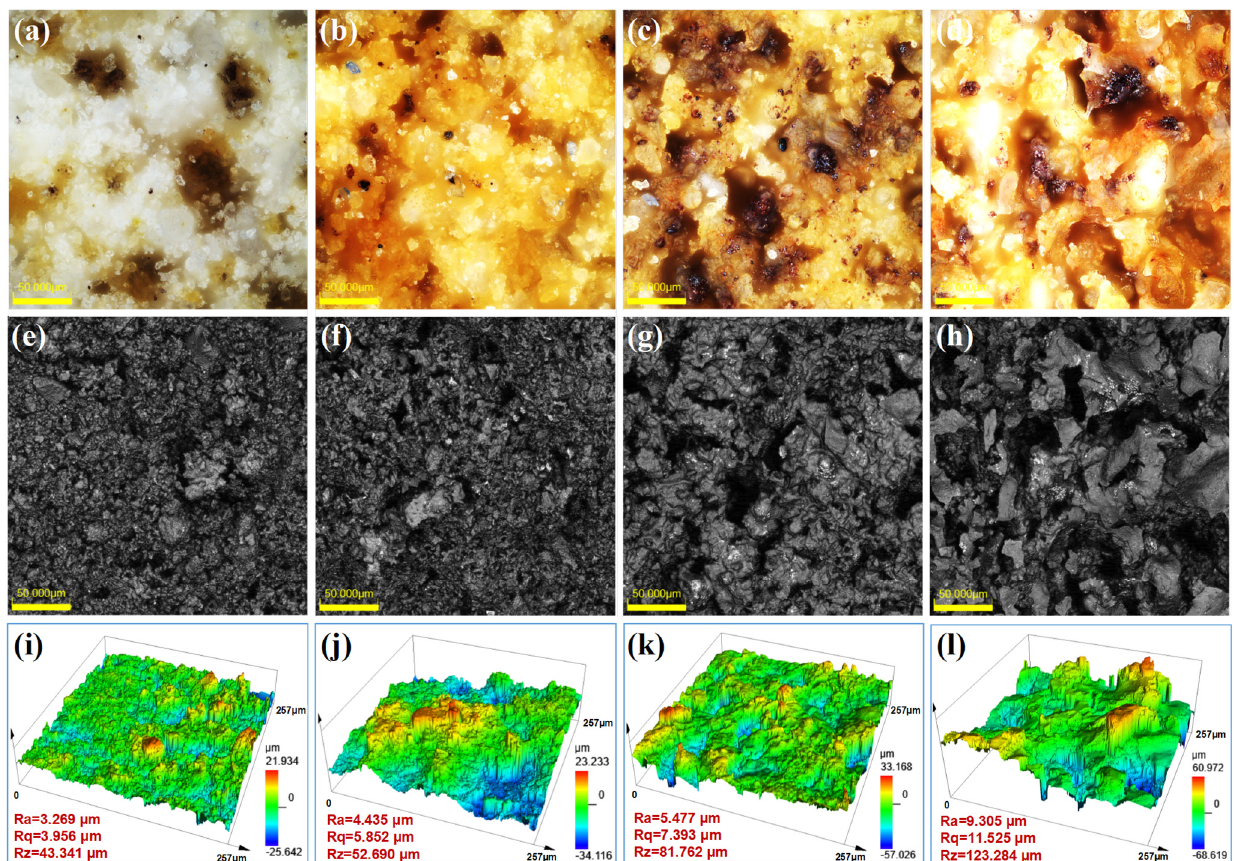
Figure 3. Cross sectional LSCM images of ceramic bricks with various sewage sludge contents sintered at 1250 °C for 40 min. ( a – d ) Laser color images; ( e – h ) white light optical images; ( i – l ) LSCM 3D images; ( a , e , i ) S1—10 wt.%; ( b , f , j ) S2—20 wt.%; ( c , g , k ) S3—30 wt.%; ( d , h , l ) S4—40 wt.%.